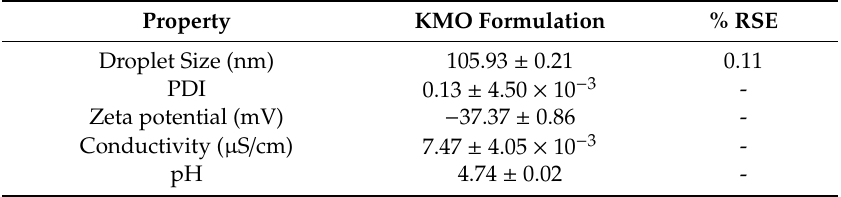
Table 9. Droplet size, PDI, Zeta potential, conductivity, and pH of the KMO